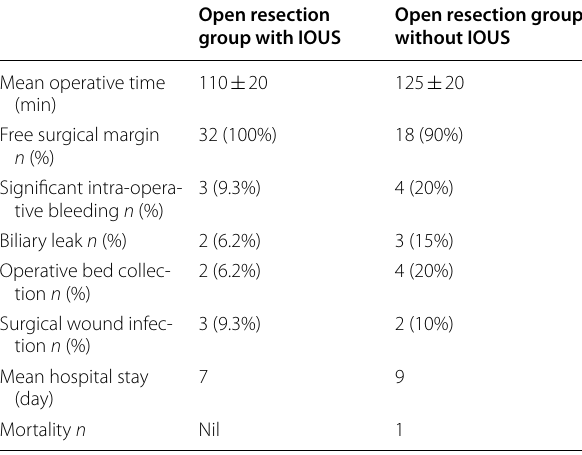
Table 2 Results of open resection group